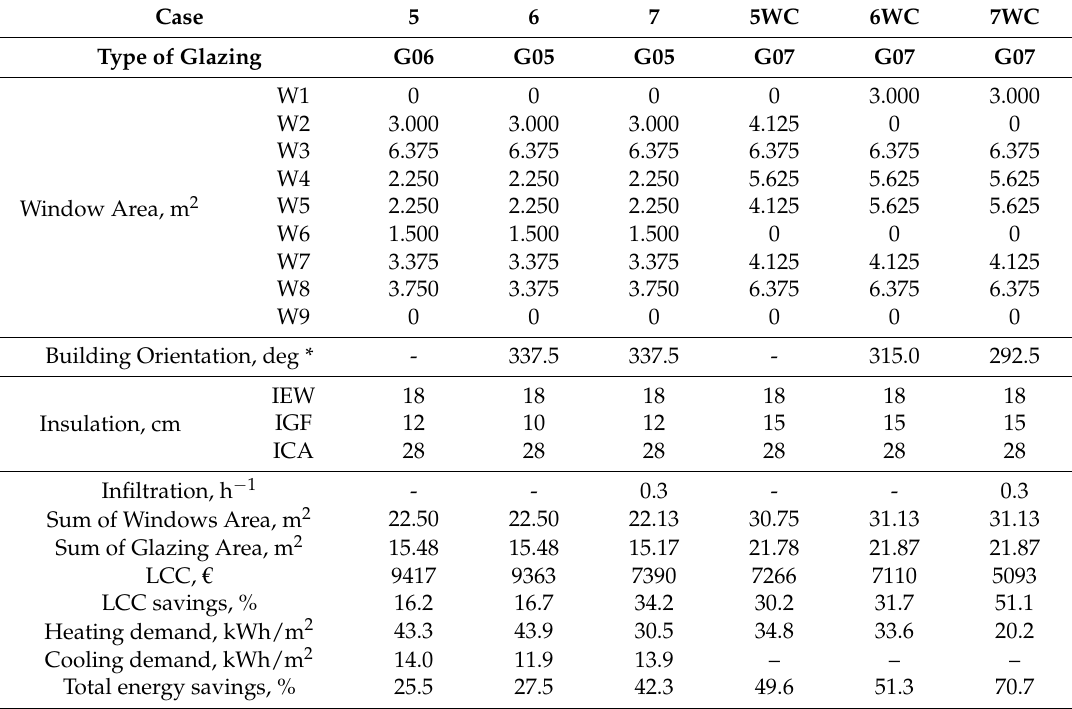
Table 10. Optimal results for cases 5, 6 and